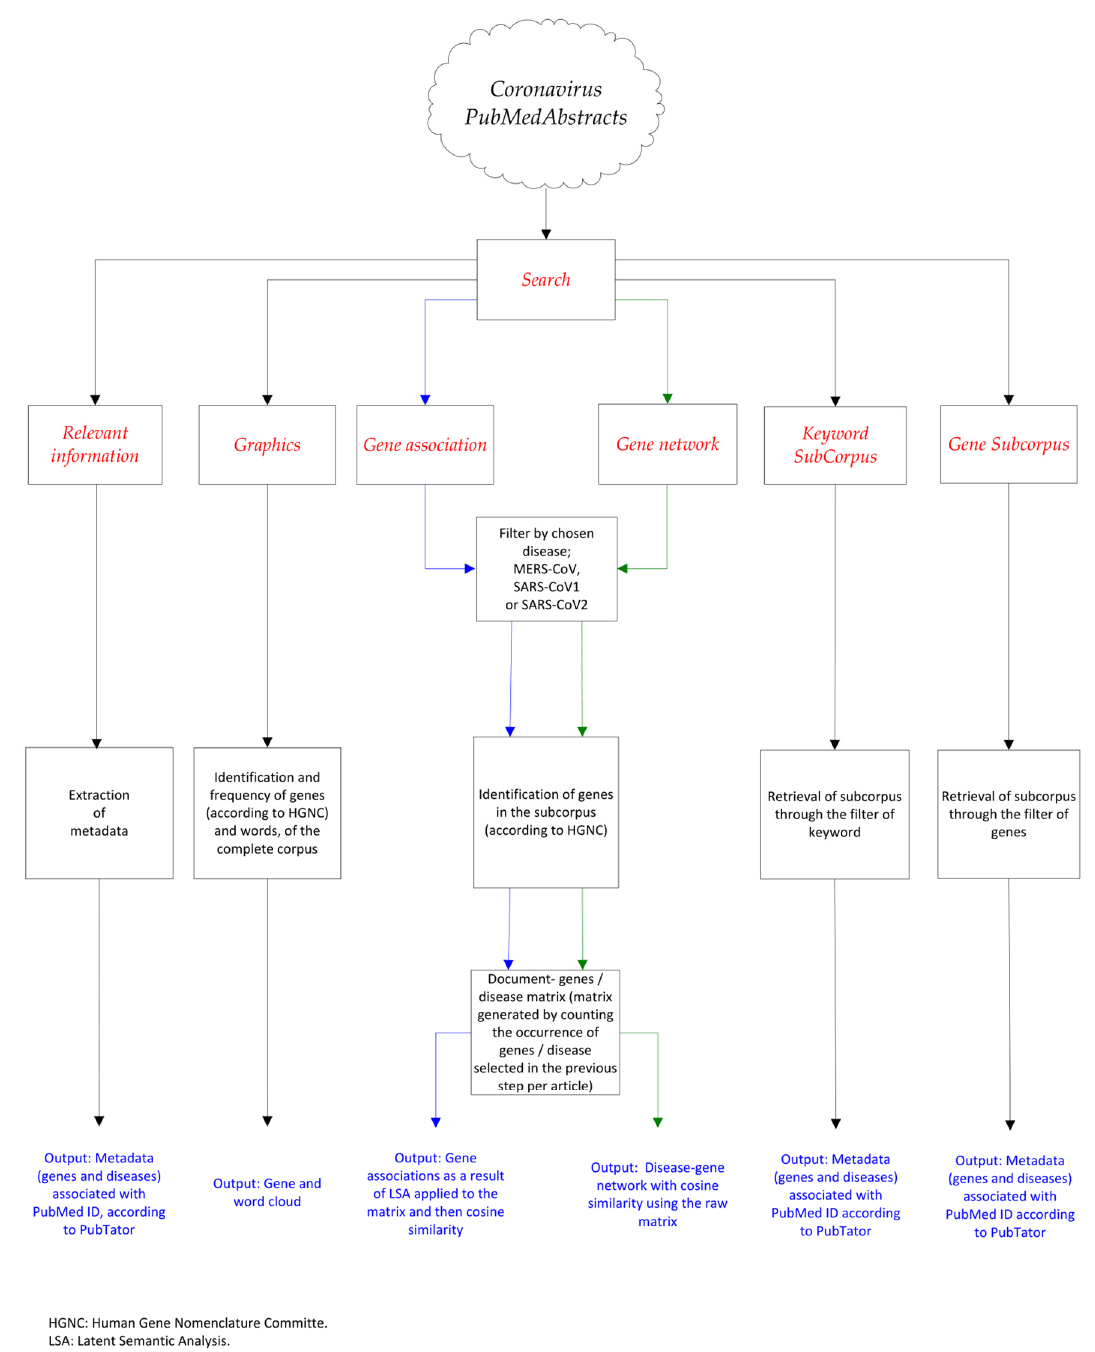
Figure 1. Diagram of the main menu, tools, and technologies used for the interactive web application, named Coronavirus Finder. The blue arrows indicate the process carried out when activating the Gene Association function and the green arrows when the Gene Network function is